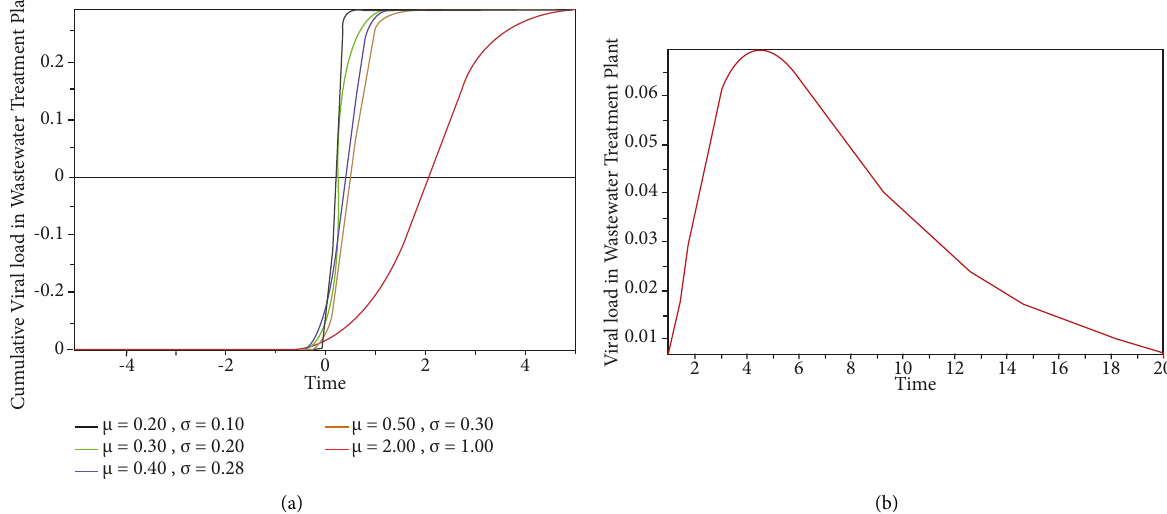
Figure 5: Gaussian model (a) predicting the possible cumulative SARS-CoV-2 load in WWTP and (b) predicting the possible SARS-CoV-2 load in